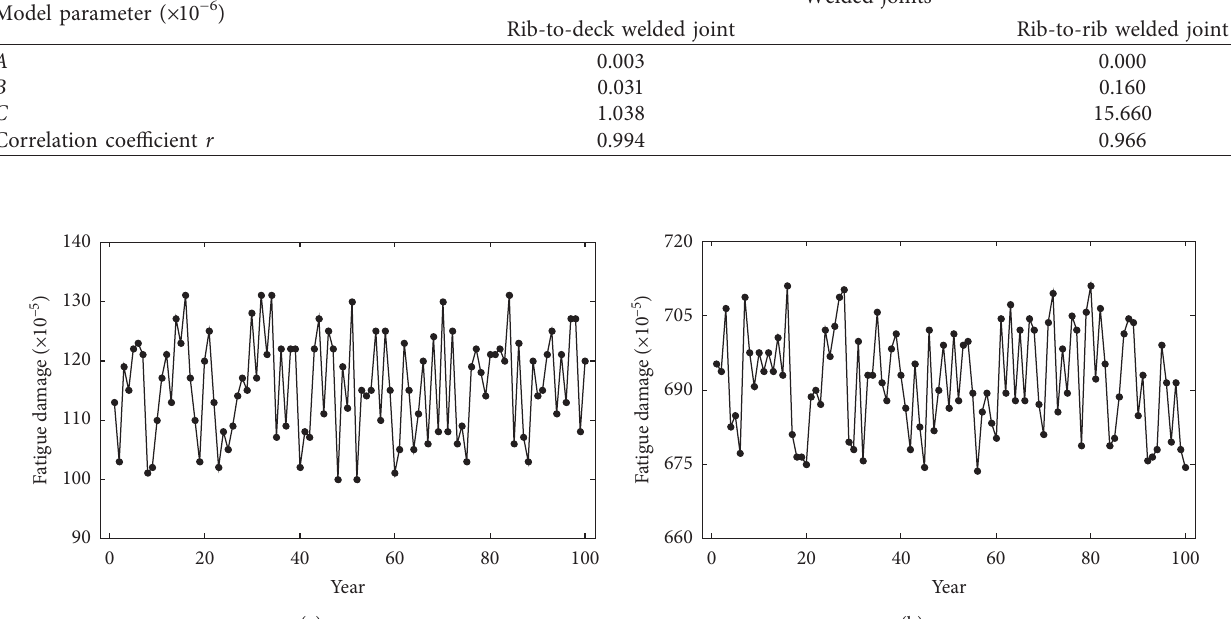
Figure 15: 100-year fatigue damages: (a) the rib-to-deck joint and (b) the rib-to-rib